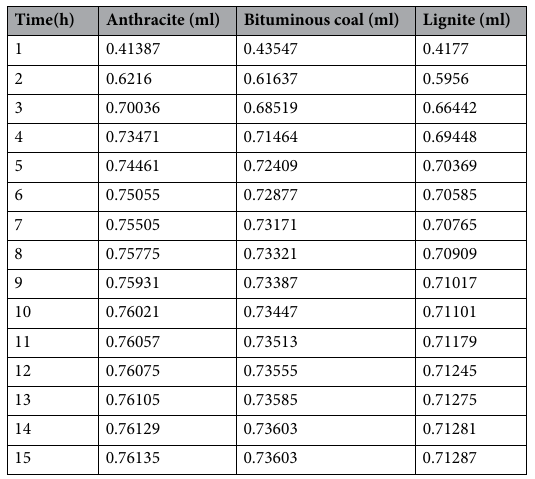
Table 5. Adsorption capacity of coal adsorbed single component NO 2 gas with